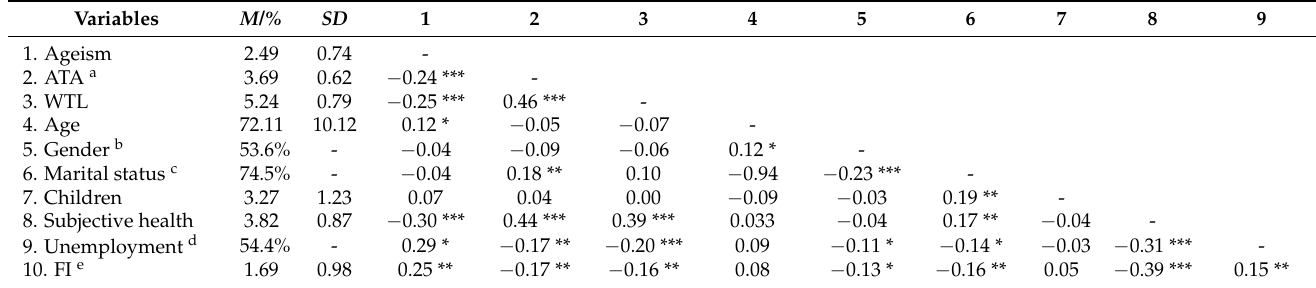
Table 3. Descriptive statistics for the study ( n =